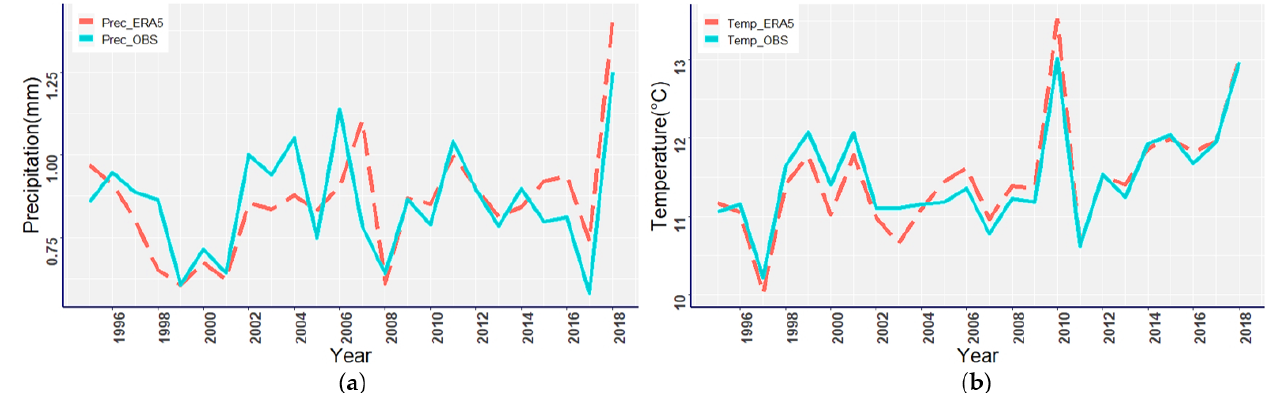
Figure 4. Comparison of observed (blue line) and ERA5 (red line) precipitation ( a ) and temperature ( b ) of the ULB. Table 4. Correlation, bias and RMSE of ERA5 data comparing to observational data over Urmia Lake basin.